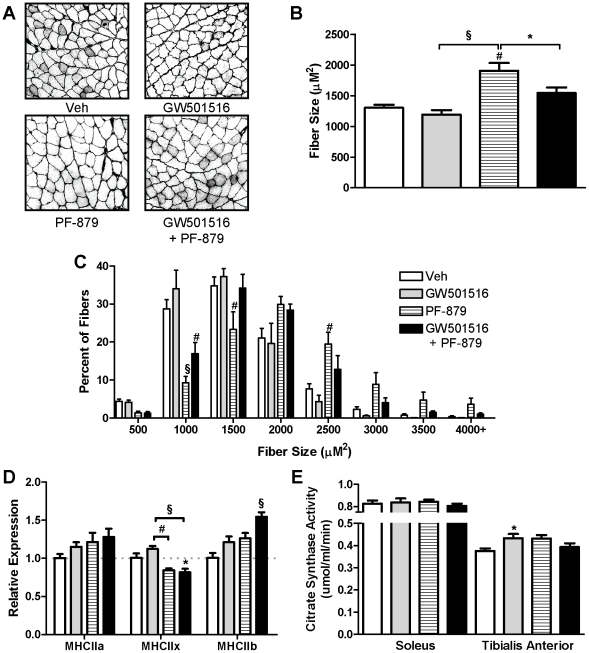
PPARδ activation increases mitochondrial activity and myostatin inhibition increases muscle fiber size in ob/ob mice.Male mice were treated for 6 weeks with either vehicle (veh, open bars), PPARδ agonist GW501516 (grey bars), myostatin antibody PF-879 (hatched bars), or GW501516 in combination with PF-879 (black bars). Representative cross-sectional images, the mean fiber area and size distribution of muscle fibers in the quadriceps muscle are presented in A, B and C, respectively (n = 5/group). Fold changes in quadriceps MHC mRNA expression levels relative to vehicle-treated mice are summarized (n = 5/group)(D). Citrate synthase activity was measured in soleus and tibialis anterior muscles (E). Data are represented as mean +/− SEM *, # and § indicate p<0.05, 0.01 and 0.001, respectively.